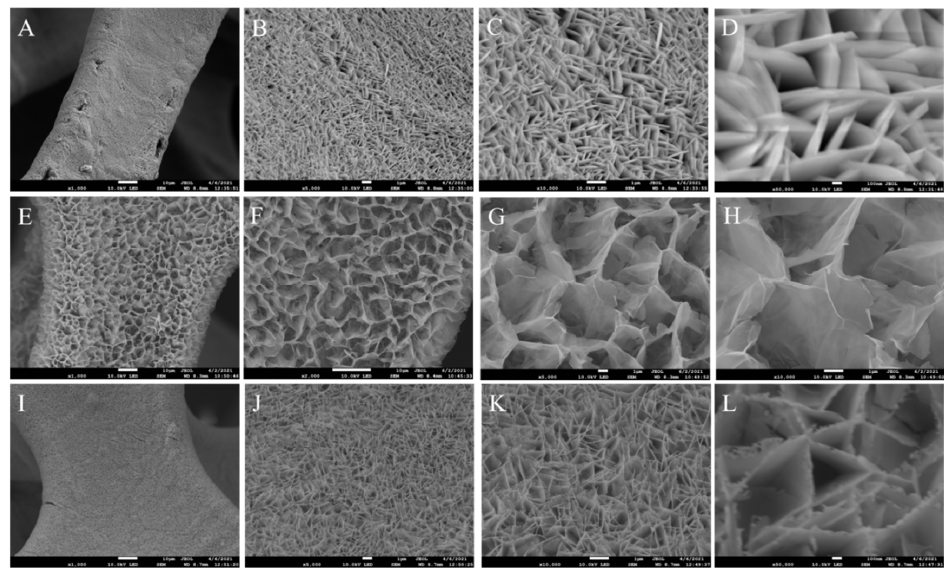
Figure 2. Low- to high-resolution SEM images showing formation of Ni 2 P nanoparticles on NiO/NiF wall-like networked nanosheet surface at different time intervals. (i) 20 min (images A – D ), (ii) 40 min images ( E – H ), and (iii) 60 min (images I – L ). Scale Bars: 10 μ m ( A , E , F , I ), 1 μ m ( B , C , G , J , K ), and 100 nm ( D , H , L ).